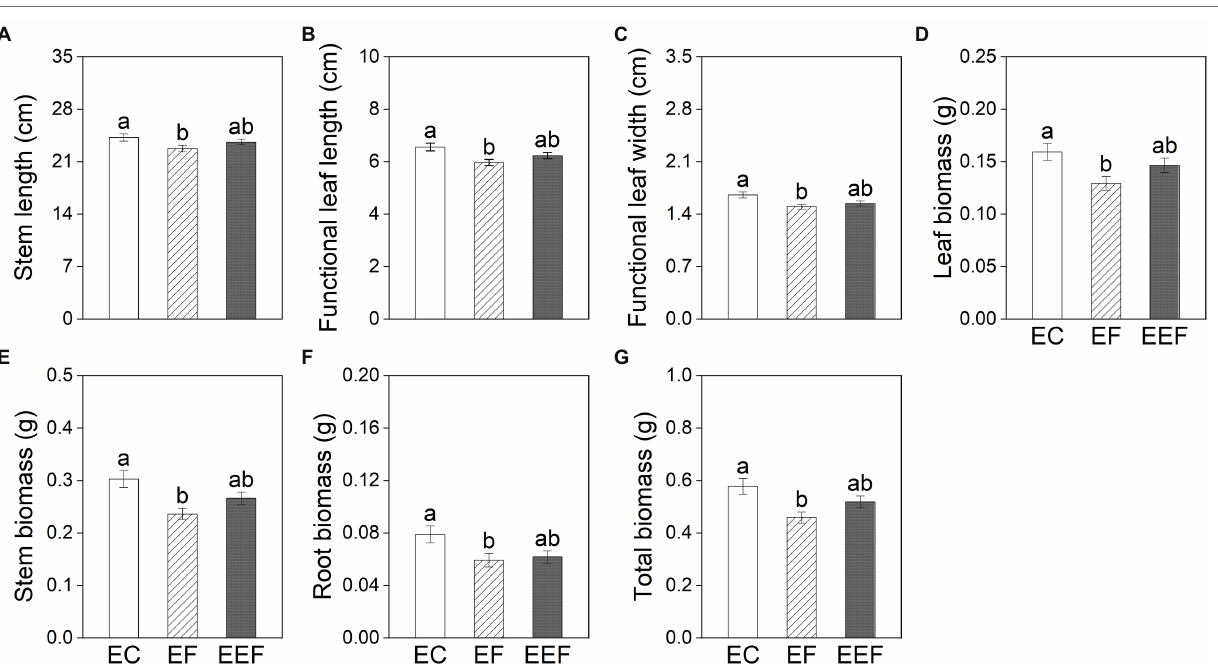
FIGURE 3 | Stem length (A) , functional leaf length (B) and width (C) , leaf biomass (D) , stem biomass (E) , root biomass (F) , and total biomass (G) of P. hydropiper subjected early control (EC), early flooding (EF), and early eutrophic flooding (EEF) at the end of subsequent treatments on day 20. Different lowercase letters represent significant differences among early